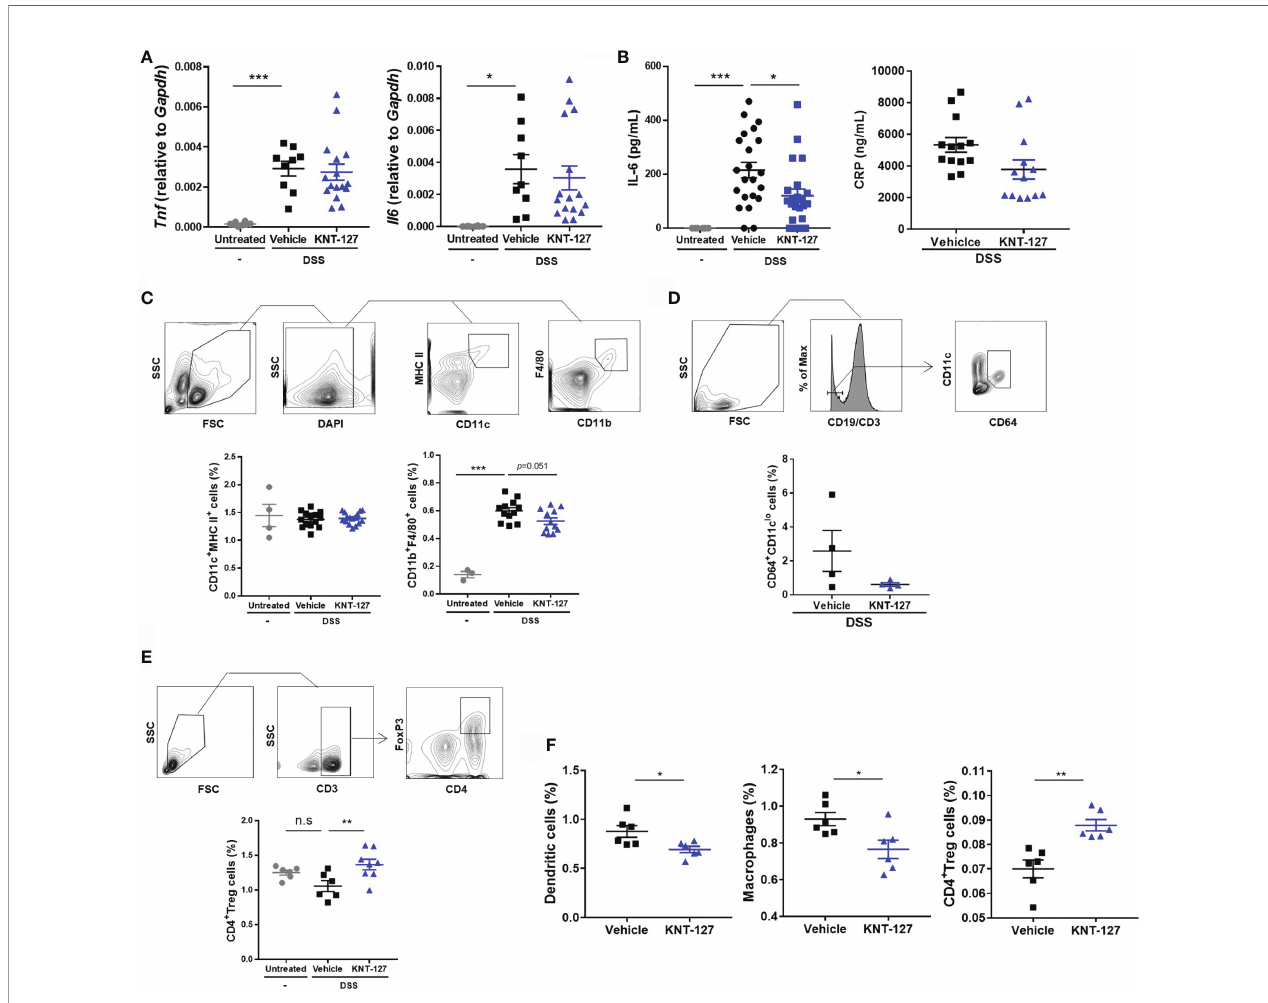
FIGURE 4 | Changes in the immune system. (A) mRNA levels of Tnf and Il6. The mRNA expression of each gene of interest was normalized to that of GAPDH by calculation of cycle threshold values. (B) Serum was collected from colitis mice, and the concentrations of IL-6 and CRP were measured by ELISA. (C) The population of macrophages (F4/80 + CD11b + cells) in the MLNs was evaluated by fl ow cytometry. (D) The frequency of CD64 + /CD11c lo cells in the MLNs of colitis mice. (E) The population of Tregs (CD3 ϵ + CD4 + Foxp3 + cells) in the MLNs was evaluated by fl ow cytometry. (F) The populations of DCs (CD11c + MHCII + cells), macrophages, and Tregs in the spleen were evaluated by fl ow cytometry. The data are shown as the mean ± s.e.m. * P < 0.05; ** P < 0.01; *** P < 0.001; n.s., not signi fi cant (one-way ANOVA followed by Dunnett ’ s multiple comparisons test for A – C, E , and two-tailed Student ’ s t-test for D, F